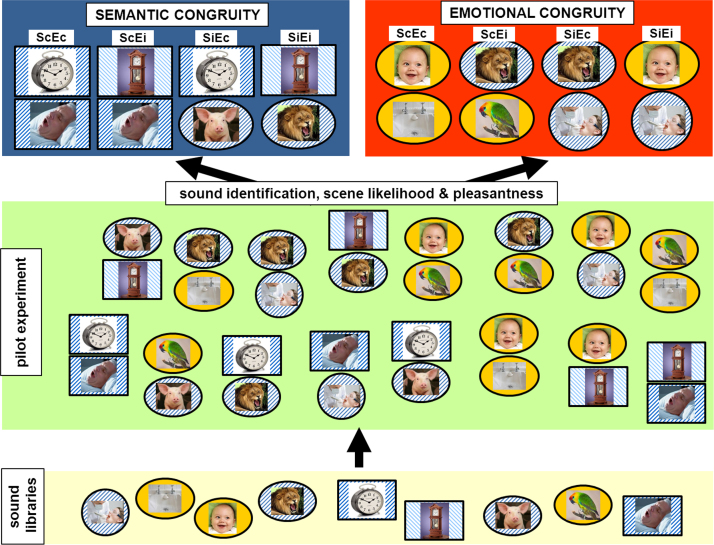
Procedure for creating auditory scene congruity tests. The diagram summarises the key steps we followed in preparing the auditory semantic and emotional congruity tests in the main experiment. An initial search of sound libraries (bottom panel; listed in Supplementary Material on-line) identified 62 sounds drawn from the broad categories of human and animal vocalisations, natural environmental noises and artificial noises (machinery and tools), of which a subset of nine sounds are represented pictorially here (from left to right, dentist's drill, splashing water, baby laughing, lion, alarm clock, grandfather clock, pig, bird chirping, snoring). These sounds were superimposed digitally as pairs into scenes (see Supplementary Material on-line) with fixed duration and average loudness. In the pilot experiment (middle panel; details in Supplementary Material on-line), the 62 constituent sounds individually were assessed for identifiability and pleasantness; and 193 sound scenes (composed from paired sounds) were assessed for likelihood and pleasantness of the combination. Auditory scene stimuli in the final semantic and emotional congruity tests (top panels; 30 trials in semantic congruity test, 40 trials in emotional congruity test) comprised the following conditions: ScEc, semantically congruous, emotionally congruous; ScEi, semantically congruous, emotionally incongruous; SiEc, semantically incongruous, emotionally congruous; SiEi, semantically incongruous, emotionally incongruous (here, semantic relatedness is coded using sound icon shape and emotional relatedness using sound icon shading). These final scene stimuli met inclusion criteria established from the pilot data (details in Supplementary Material on-line): all individual constituent sounds met a consensus identifiability criterion and in addition, scenes in the final semantic congruity test met condition-specific likelihood criteria while scenes in the final emotional congruity test met condition-specific pleasantness criteria. For each test, the ‘nuisance’ congruity parameter (emotional congruity in the semantic congruity test; semantic congruity in the emotional congruity test) was also controlled within a narrow range across conditions.